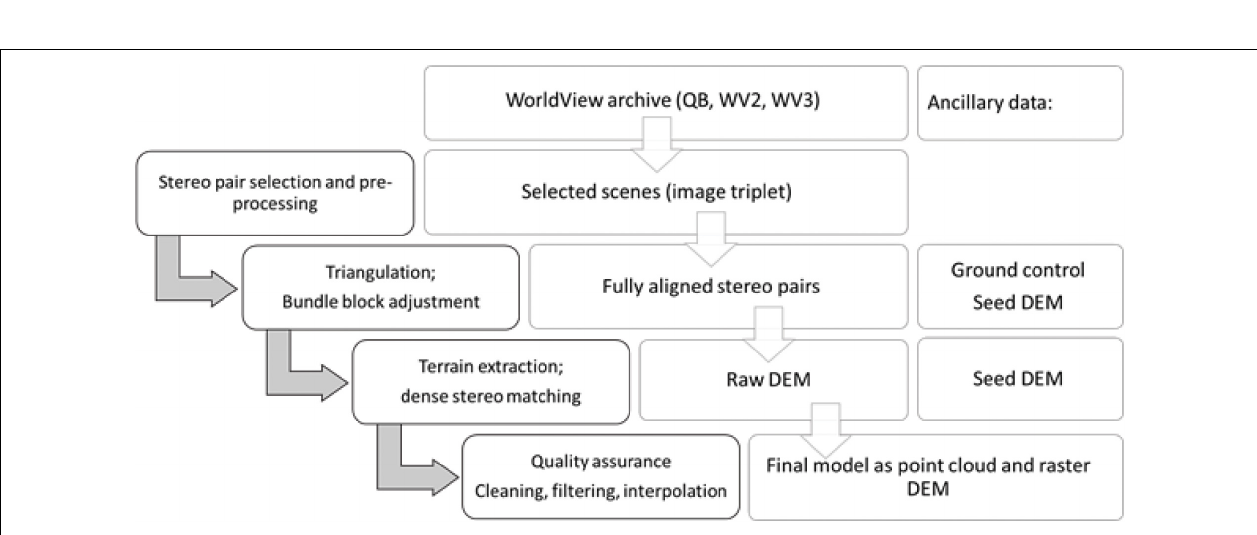
FIGURE 5 | Geodetic control network (red triangles) with photogrammetric GCP (yellow circles) overlaid on OSM; the figure also shows the displacement of OSM compared to the GCN.